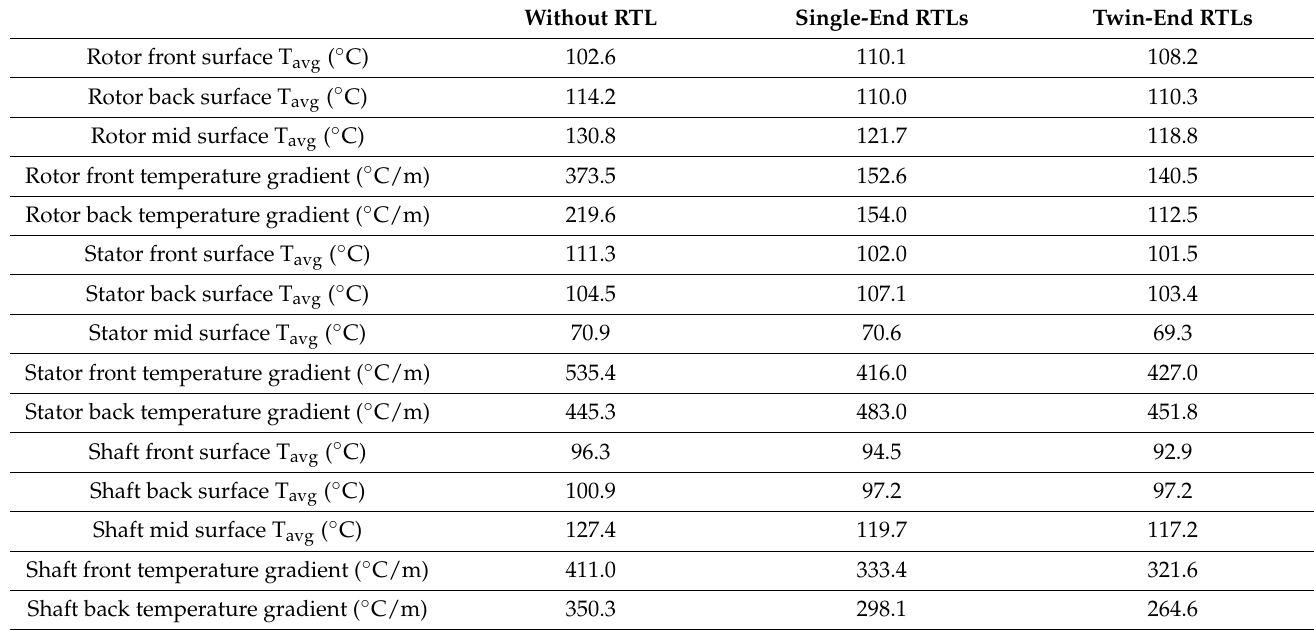
Table 4. Averaged temperatures and axial temperature-gradients of PMSEMs at T 0